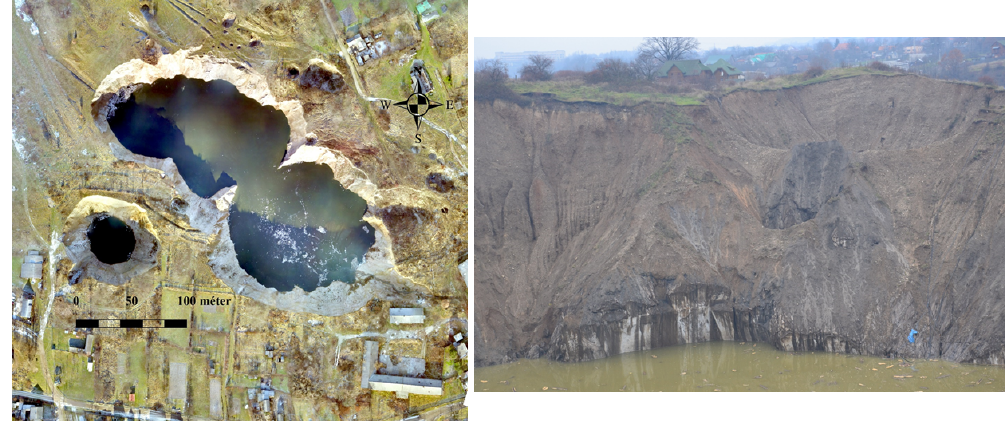
Figure 1. Pictures of some sinkholes in the Solotvyno salt mining area (credit: Sándor Gönczy).